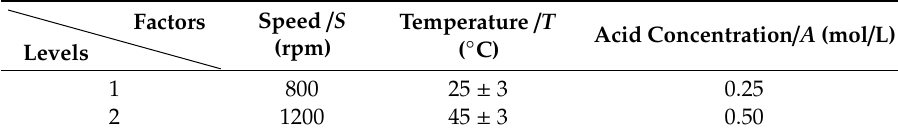
Table 2. Levels of test design parameters.